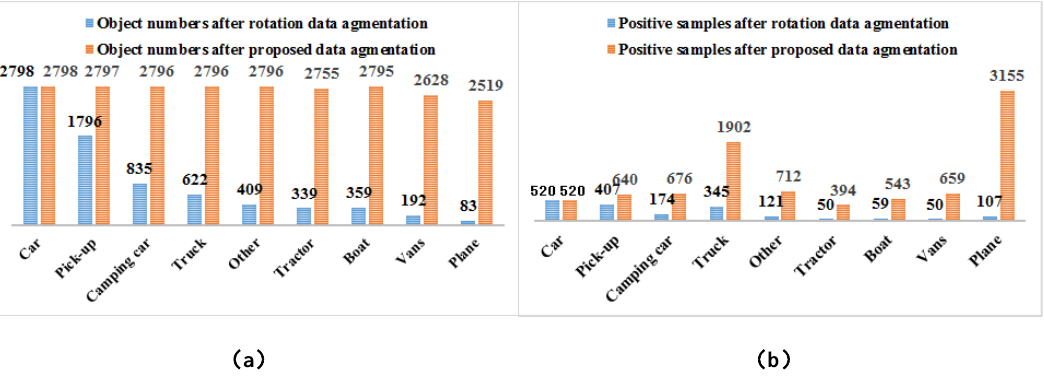
Figure 10. Comparison between rotation augmentation and proposed method of Group 1. ( a ) Object numbers ( b ) Positive samples (IOU > 0.7).